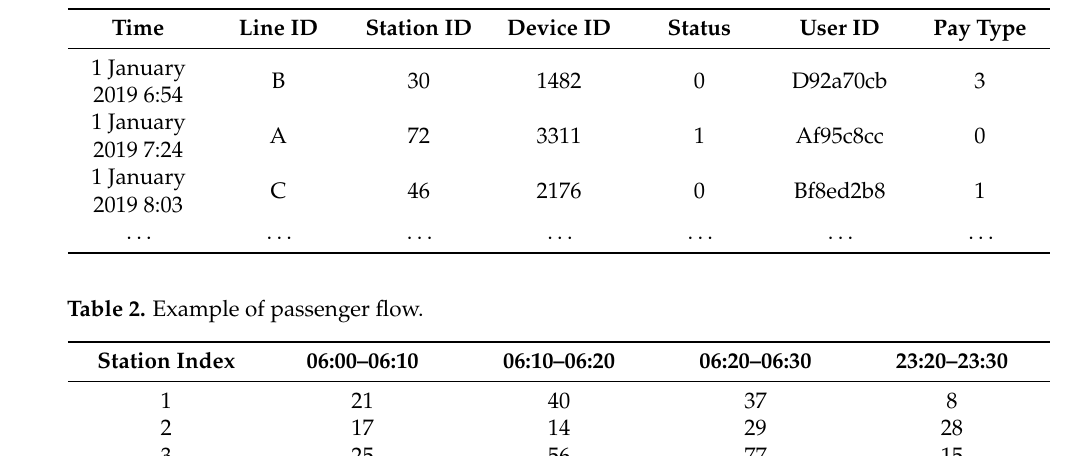
Table 1. Example of original data record.